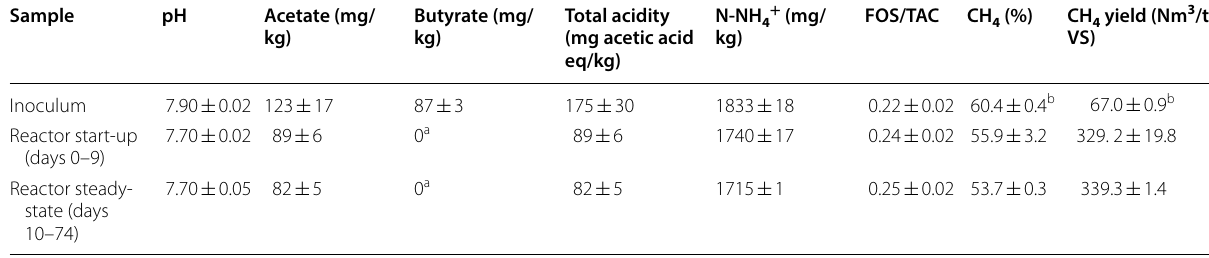
Table 1 Physico-chemical characteristics of the inoculum and the reactor digestate at the start-up and steady-state